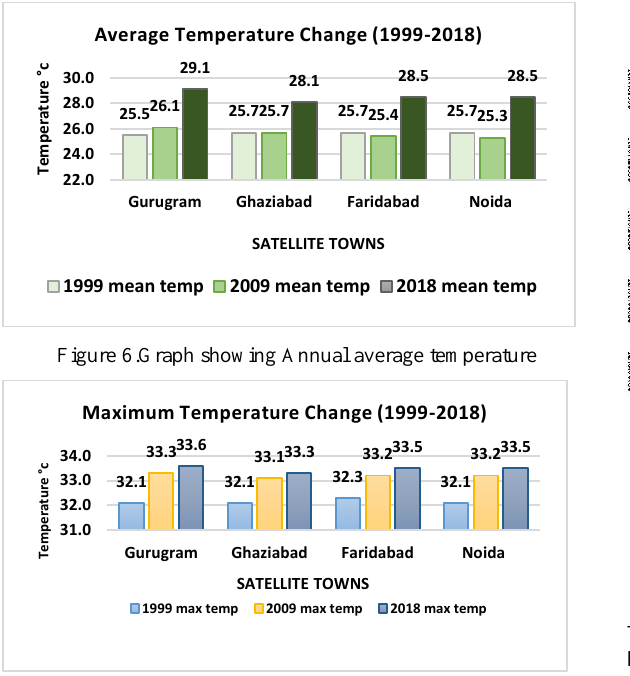
Figure 6.Graph showing Annual average temperature change